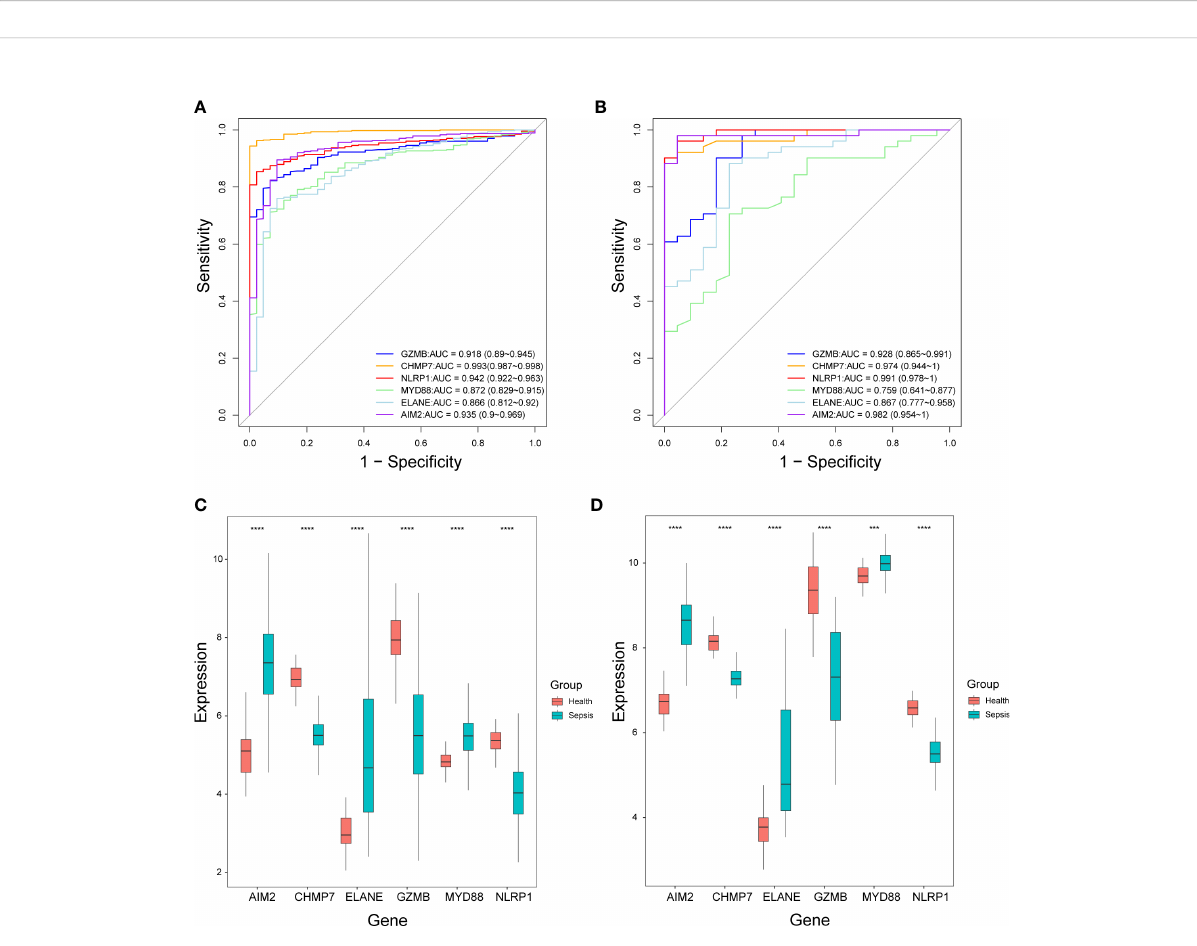
FIGURE 8 The performance of the selected six pyroptosis-related genes in the diagnosis of sepsis. (A, B) Receiver operating characteristic curves in the GSE65682 dataset (A) and GSE95233 dataset (B) . AUC, Area under the curve. (C, D) Box plots of the expression levels of the six genes between sepsis patients and healthy individuals in the GSE65682 dataset (C) and GSE95233 dataset (D) . *** P < 0.001, **** P < 0.0001.